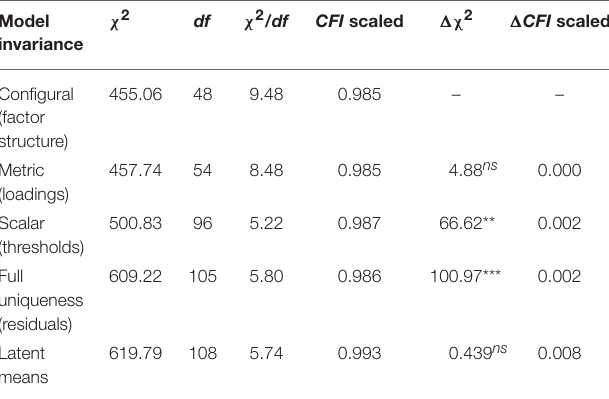
TABLE 6 | Model comparison between Portugal and Brazil. Model